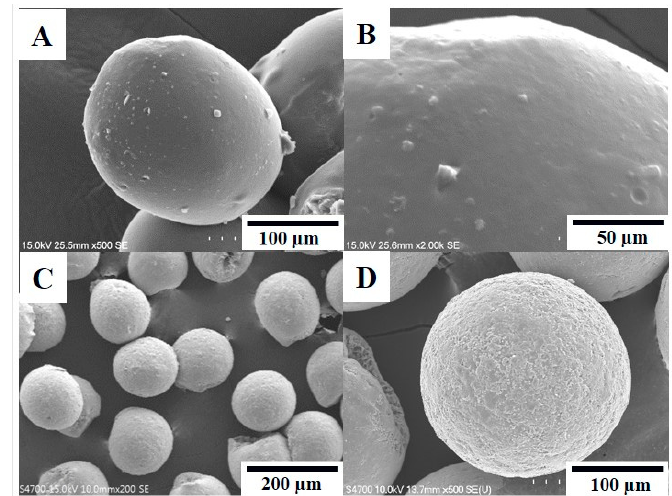
Figure 4. The ( A ) and ( B ) are SEM images of VBL-loaded chitosan composite particles. The ( C ) and ( D ) are SEM images of VBL-loaded SPIO NPs–chitosan composite particles.